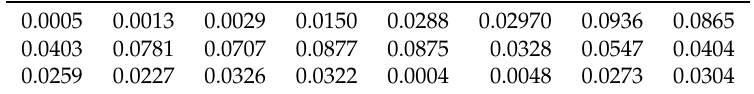
Table 6. Coefficients α 2 for the best MC solution (natural order from left to rigth). k